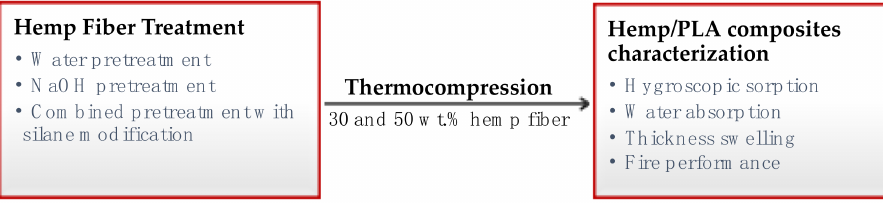
Figure 1. Schematic representation of the research objective.